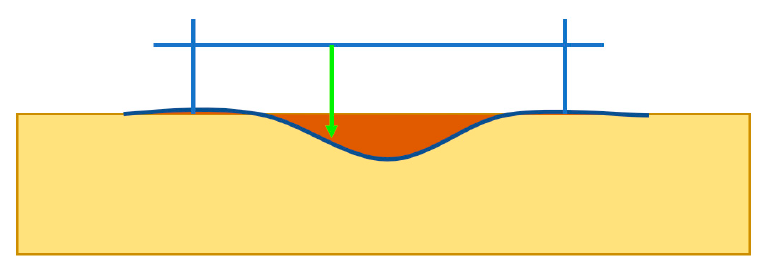
Figure 8. Profile meter measurement using a laser rangefinder to calculate the value difference between the compacted and undisturbed soil surface.